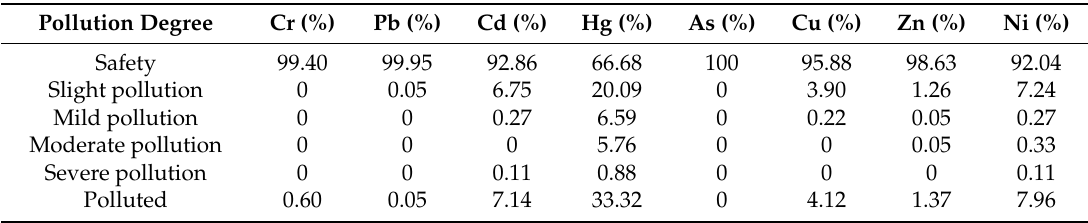
Table 7. Pollution grade classification of the SPIs in soil ( N = 1822).